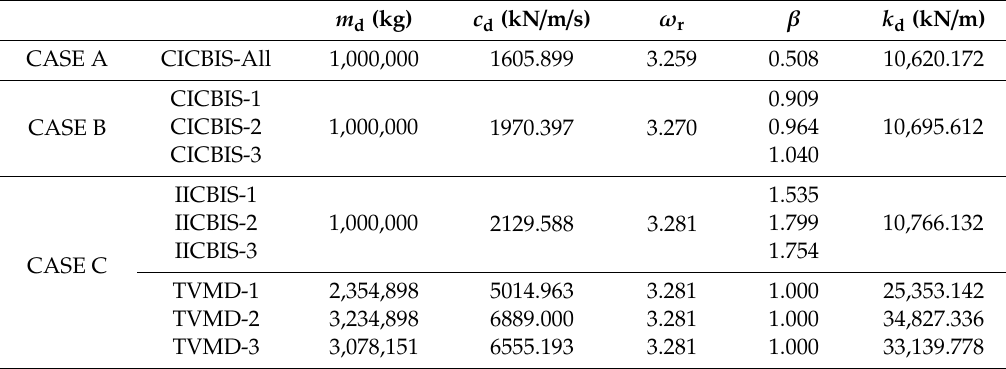
Table 2. Optimal results of CASE A, CASE B, CASE C.